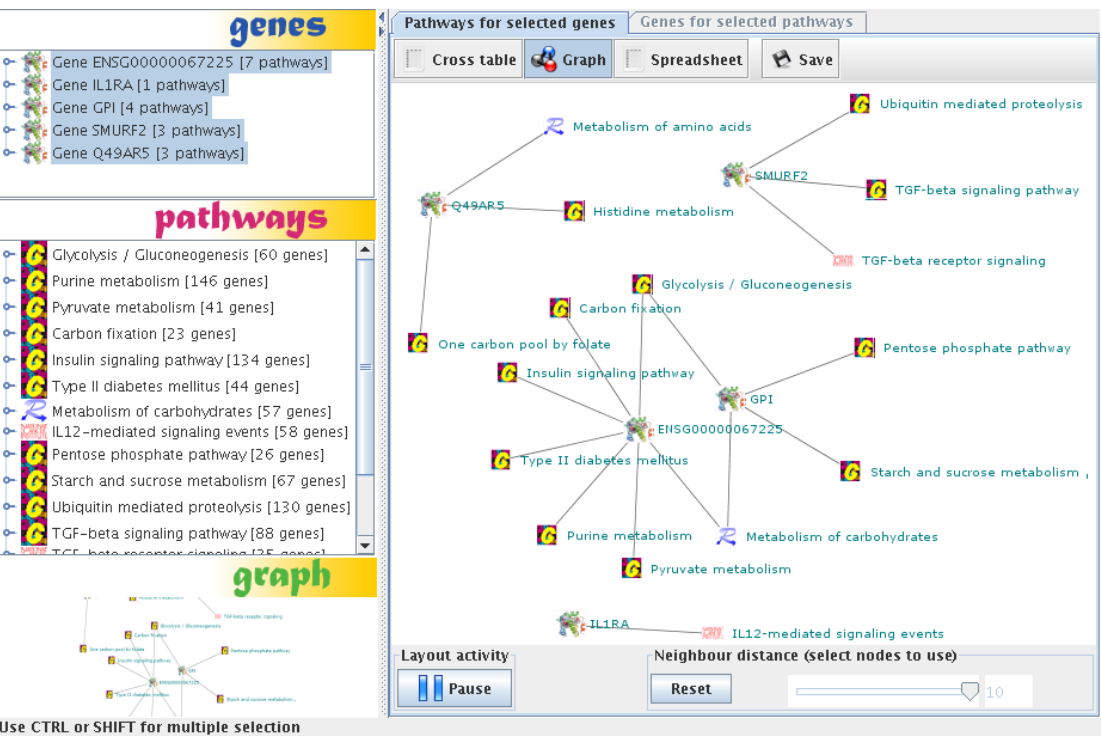
Figure 3: Interactive graph component representing identified interactions between genes and pathways. The graphical representation can be customized by the user hiding unwanted associations (based on a neighbour distance principle). All the graphics elements (genes and pathways) are clickable for obtaining specific information.